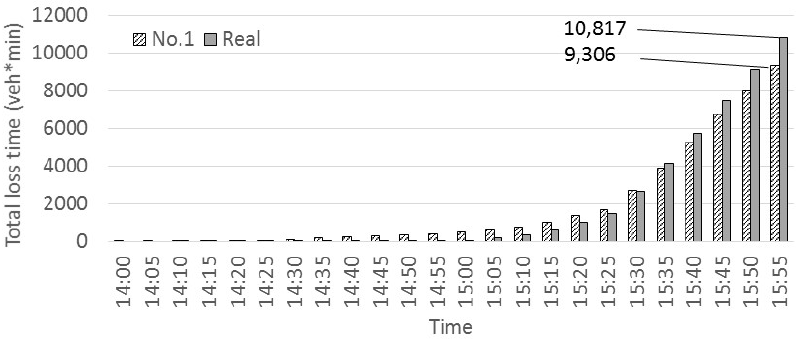
Figure 7. Comparing loss time (No.1 and real data).